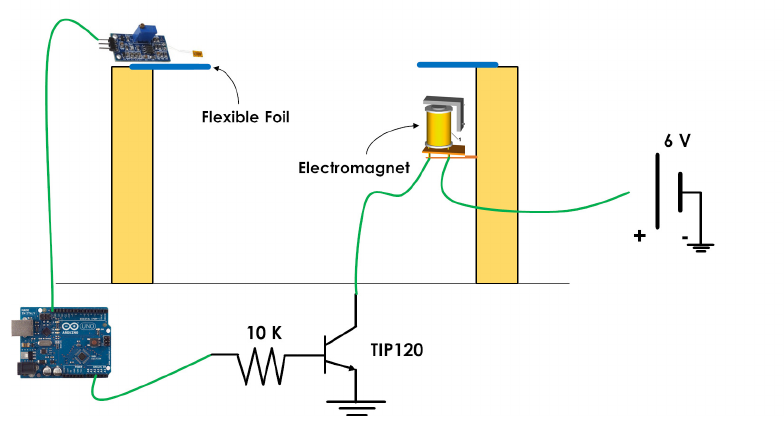
Figure 2. Schematic representation of demo